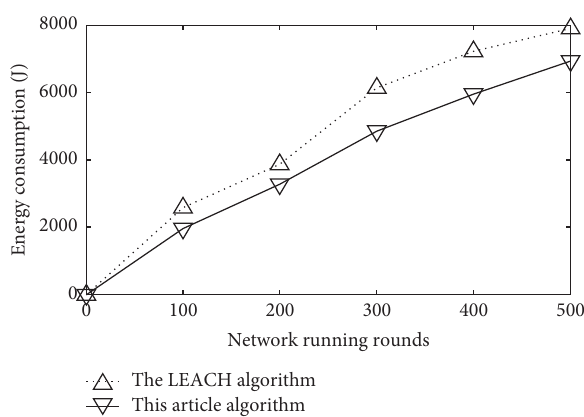
Figure 2: Energy consumption comparison in this article’s algo- rithm and the LEACH algorithm under different network running rounds (when s �